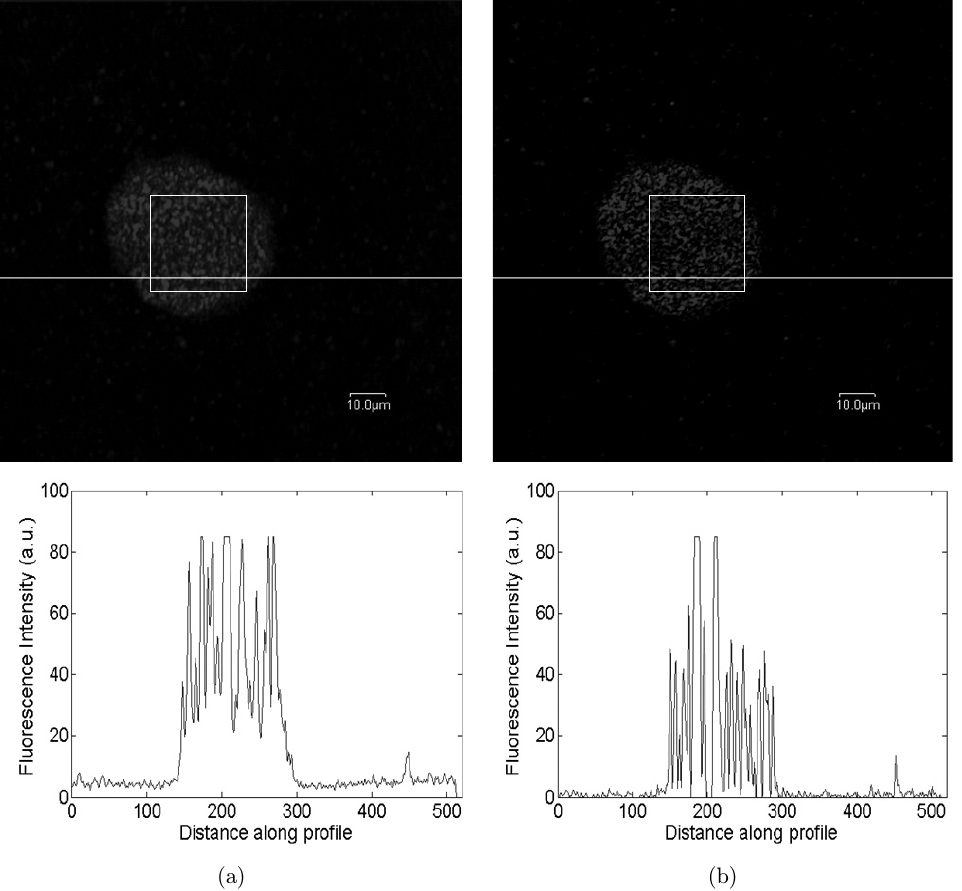
Fig. 13. (a) CM and (b) FMM images of cluster of TiO 2 nanoparticles. The plot at the bottom of the images shows the intensity pro¯le of the white lines in the images. Peaks are more distinct with better contrast can be